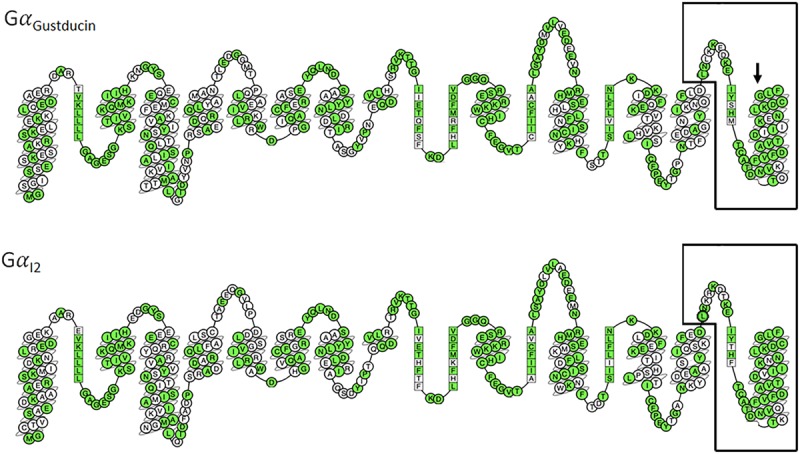
Comparison of 2D snake representations of GαGustducin and Gαi2 [constructed via GPCRdb (Isberg et al., 2016)]. Amino acids are labeled following the Ballesteros–Weinstein numbering system. Conserved amino acids are colored green. The final 44 amino acids are known to be necessary for T2R coupling and signaling (Ueda et al., 2003) and are highlighted by black boxes. Arrow points to the amino acid (Glycine352) in GαGustducin that disrupts T2R coupling when mutated to proline (Ruiz-Avila et al., 2001).